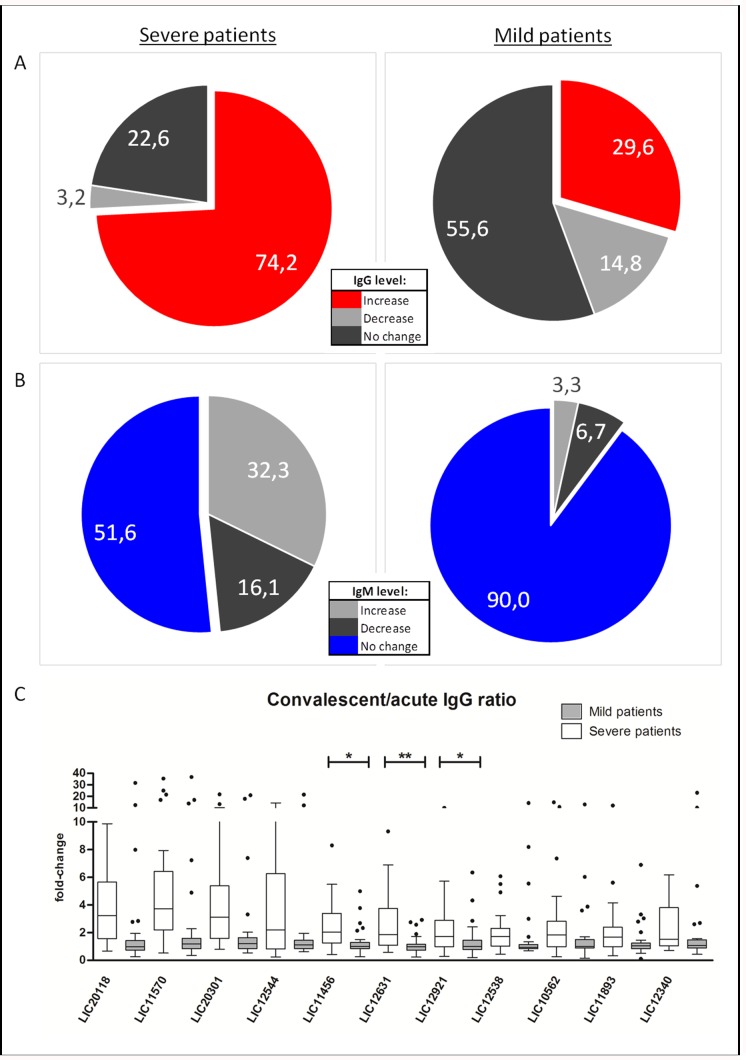
IgM and IgG antibody kinetics in patients with mild and severe leptospirosis.Percentage of patients that showed increase, decrease or unchanged IgG (A) and IgM (B) levels from acute to convalescent phases. Patients with severe disease are shown on the left and patients with mild form, on the right. (C) Boxplot shows the IgG fold-change (y-axis) of mild (dark gray) and severe (light gray) groups for each of the antigens in the x-axis. Significant differences are marked with star (*p<0.01; **p<0.001).